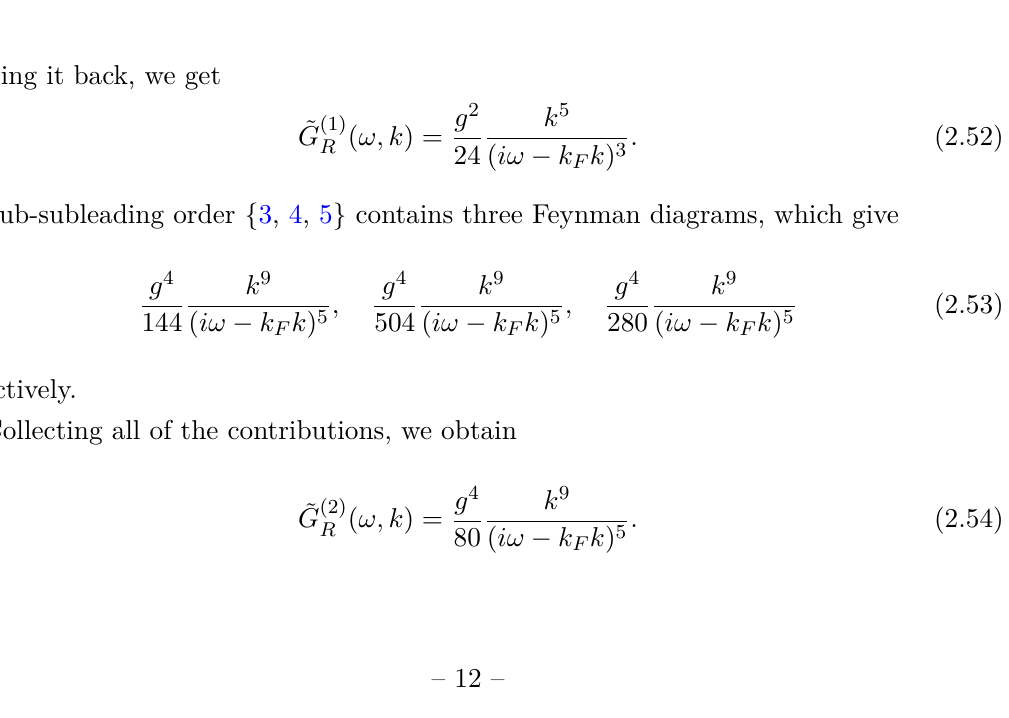
Figure 5 . Sub-subleading